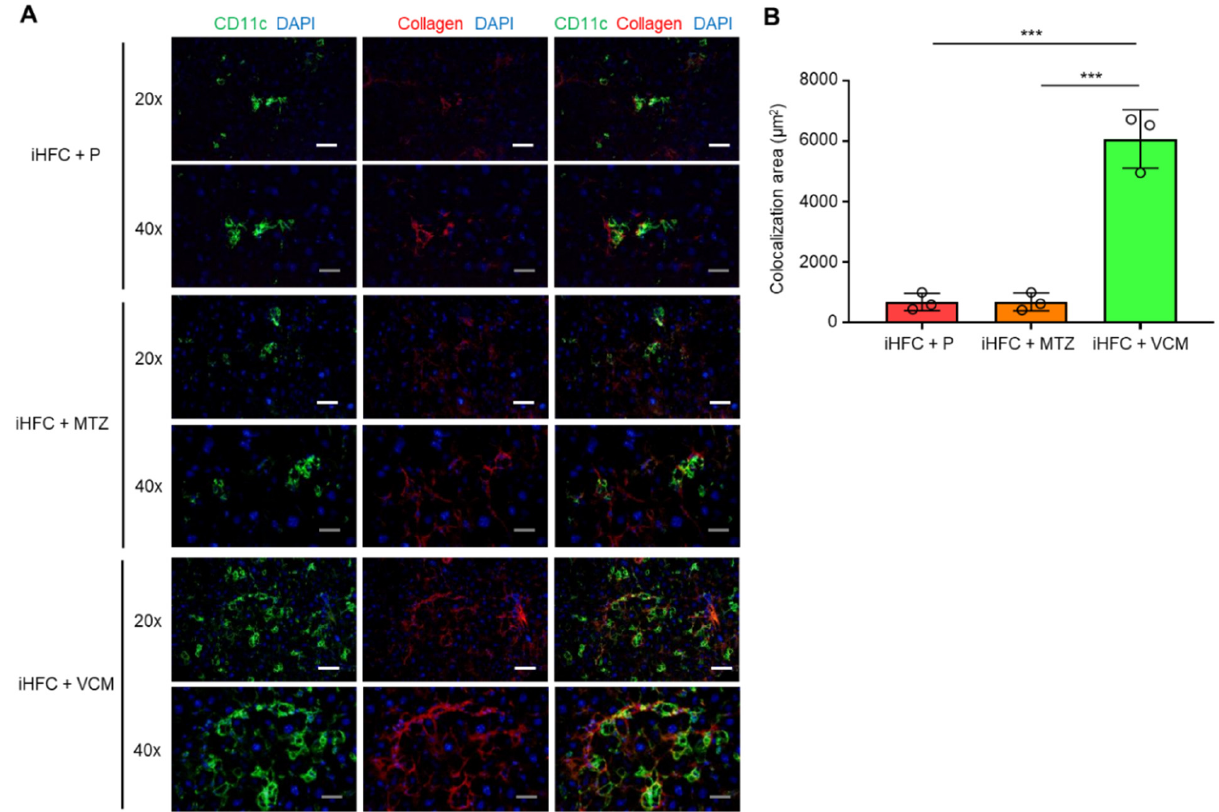
Figure 7. VCM treatment augments iHFC diet-induced accumulation of CD11c + cells which are co-localized with collagen fibers. ( A ) Representative histological images (20 × or 40 × magnification) of fluorescent immunohistochemistry for CD11c, collagen type 1, and DAPI of the livers from placebo- or antibiotic-treated TSNO mice on the iHFC diet for 8 weeks. White scale bars, 100 μ m. Gray scale bars, 50 μ m. ( B ) Co-localization areas were calculated as described in Figure S6 and the Materials and Methods. Data are shown as means ± SD. *** p < 0.001.